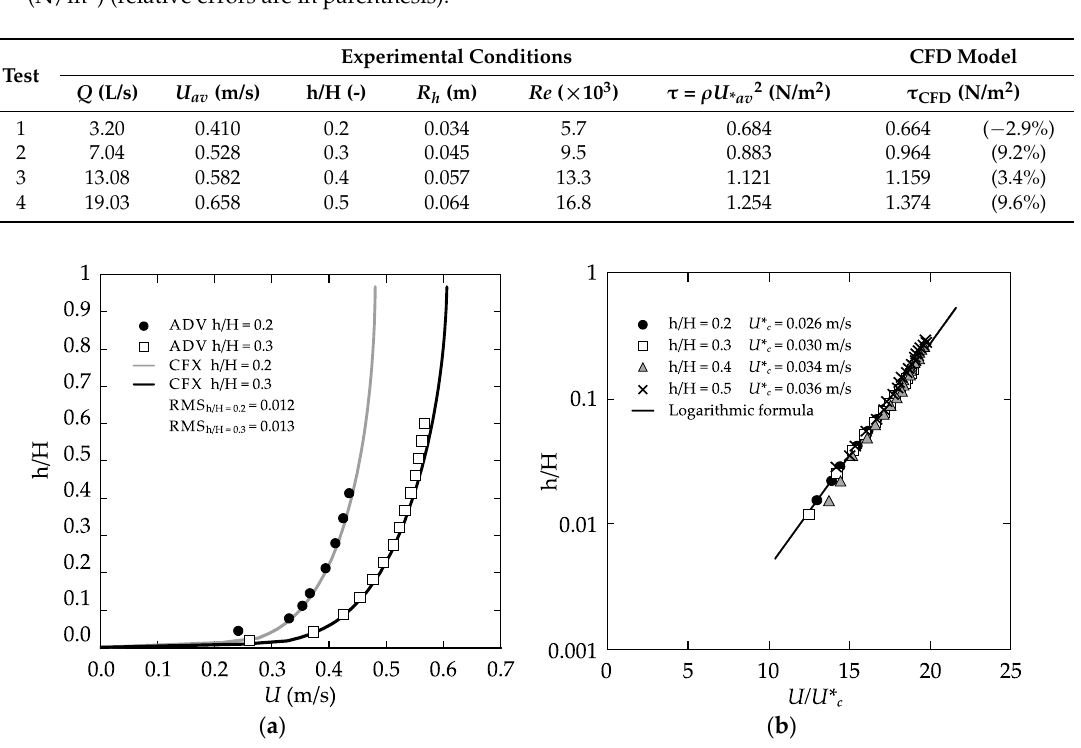
Table 2. Experimental parameters: discharge Q (L/s), averaged velocity U av (m/s), filling ratio h/H (dimensionless), hydraulic radius R h (m), Reynolds number Re , average friction velocity U *av (m/s). Total shear stress results from the experimental methodology τ and output modelling shear stress τ CFD (N/m 2 ) (relative errors are in parenthesis).